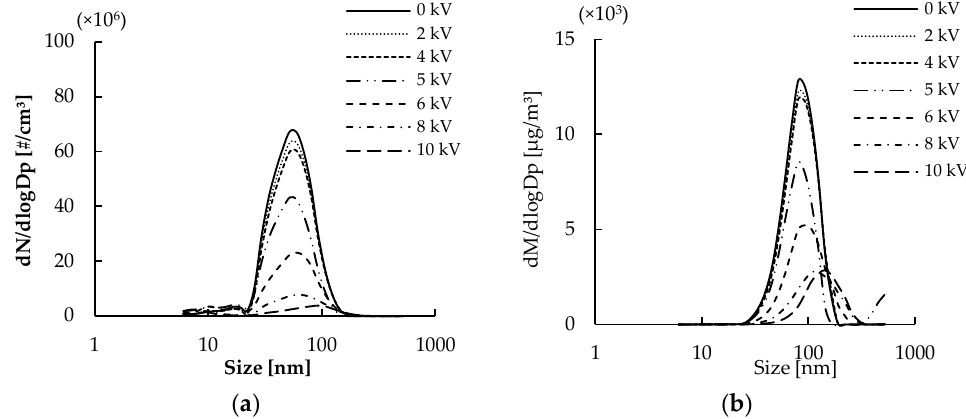
Figure 5. Average number-mass size distributions of PM without Porous Material and NTP when ( a ) Particle number size distributions; ( b ) Particle Mass size distributions.